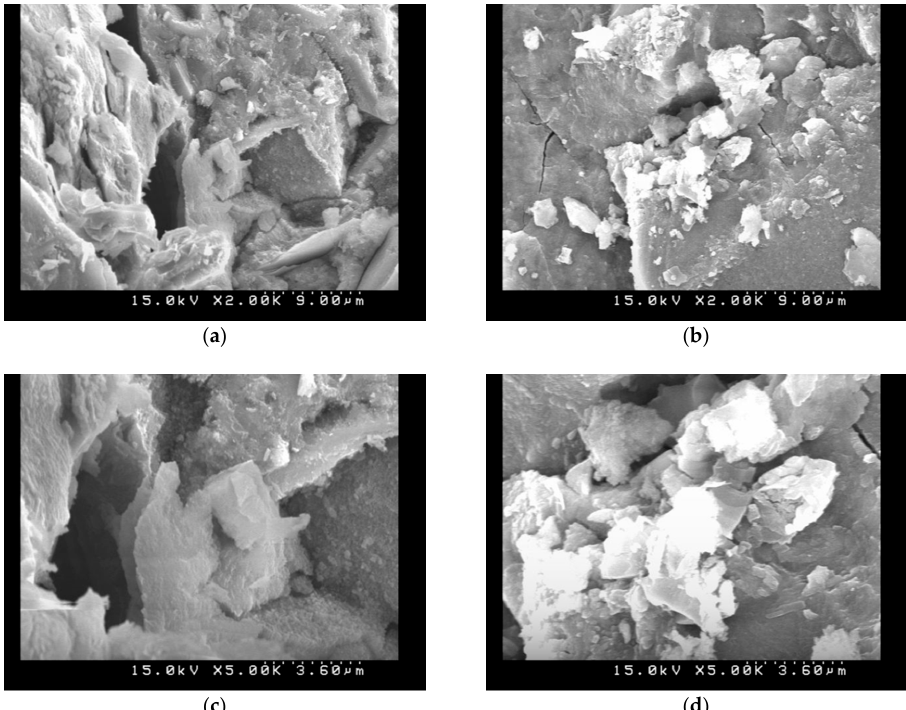
Figure 9. SEM images (S/A = 0.2, L/B = 0.5, P/A = 0.535): ( a ) without carbonation (2000×); ( b ) with carbonation (2000×); ( c ) without carbonation (5000×); and ( d ) with carbonation (5000×).